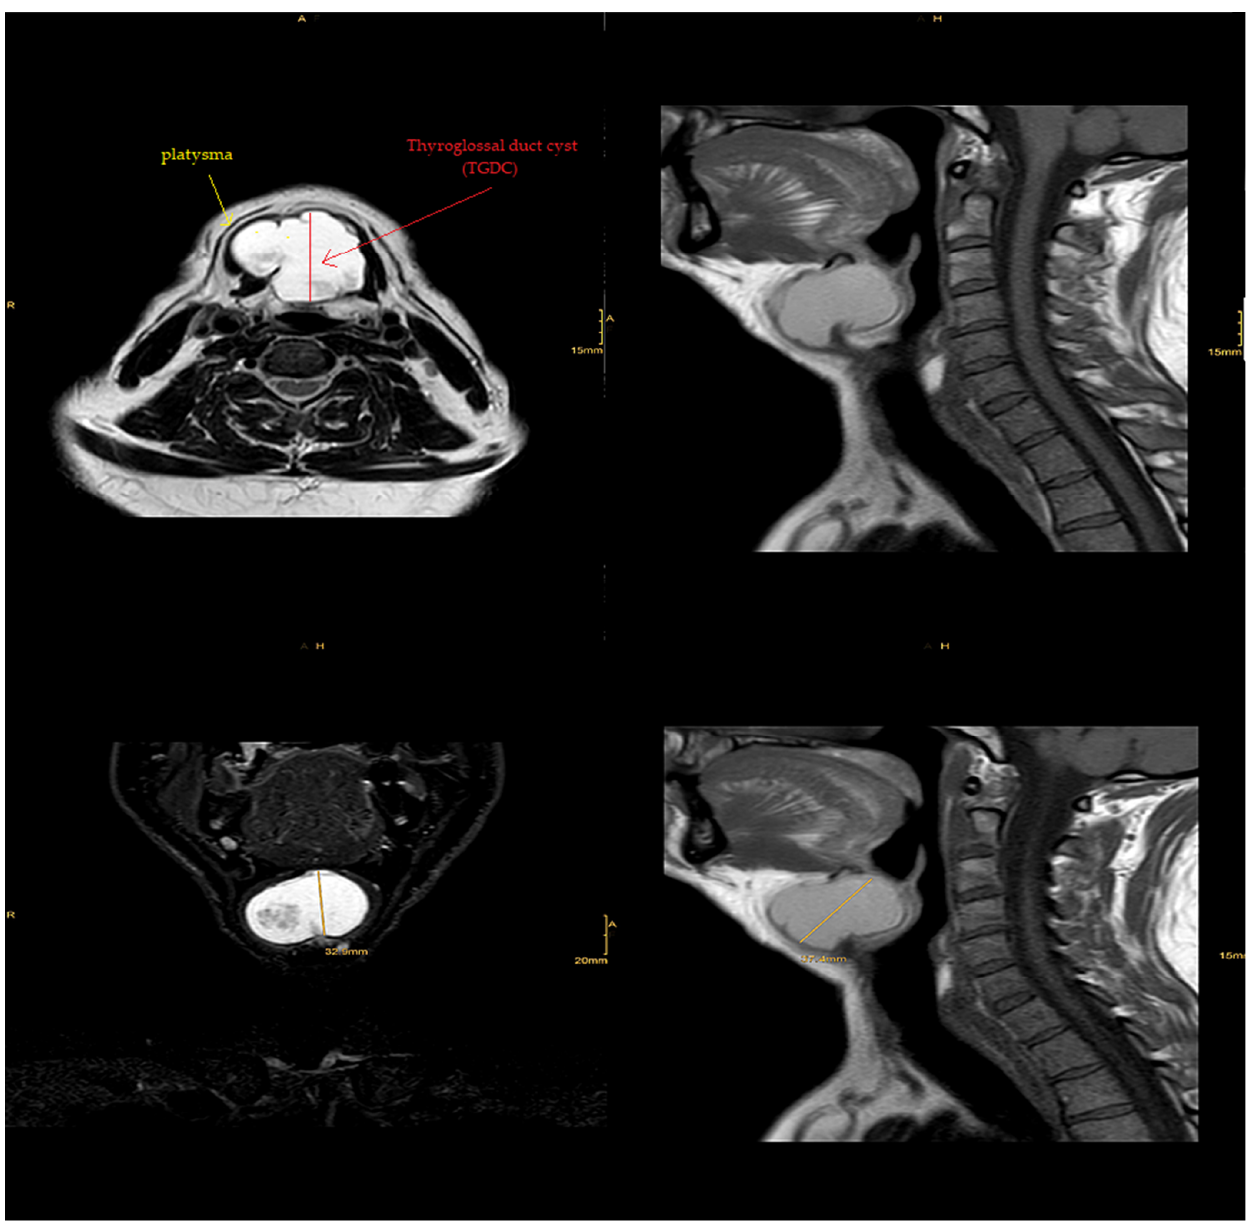
Figure 3. MRI image of the neck’s soft tissues (native and IV KM) showing suprahyoid thyroglossal cyst located posterior to the platysma.